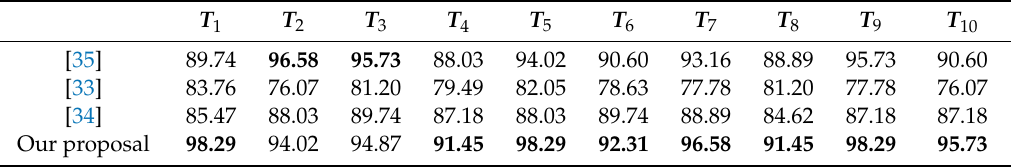
Table 4. Accuracy in percentage of di ff erent fault diagnosis strategies over 10 periods. T 1